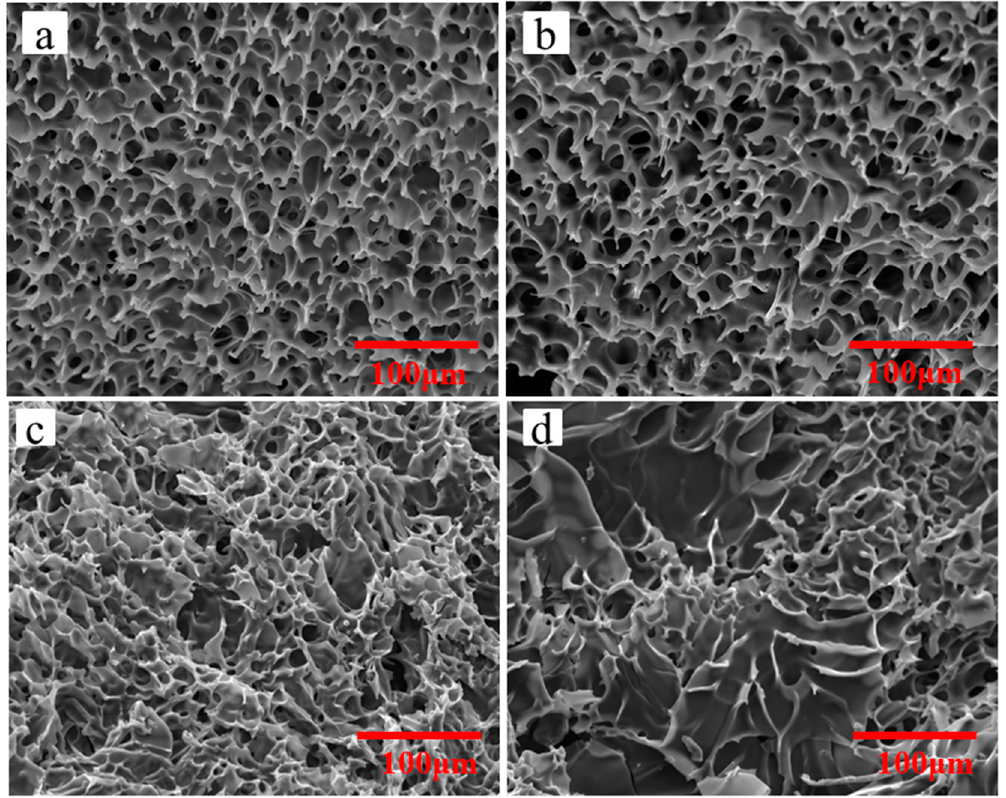
Figure 9. Micrograph of emulsions suffering from 10 min heat via different temperature : ( a ) 25 °C ; ( b ) 50 °C ; ( c ) 70 °C; and ( d ) 90 °C.